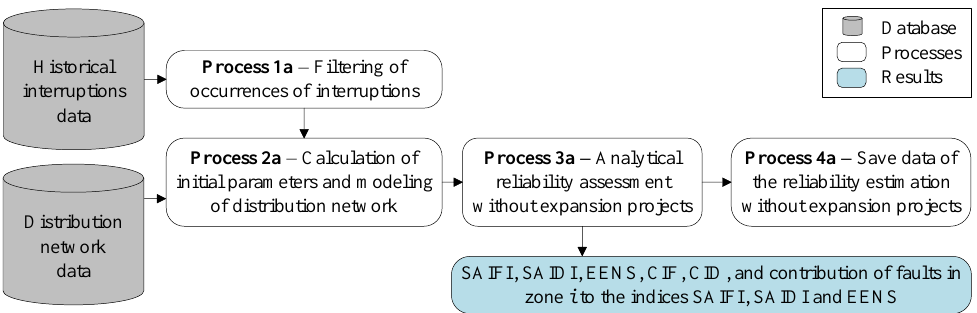
Figure 1. Flowchart of reliability assessment assuming no expansion of the distribution network.